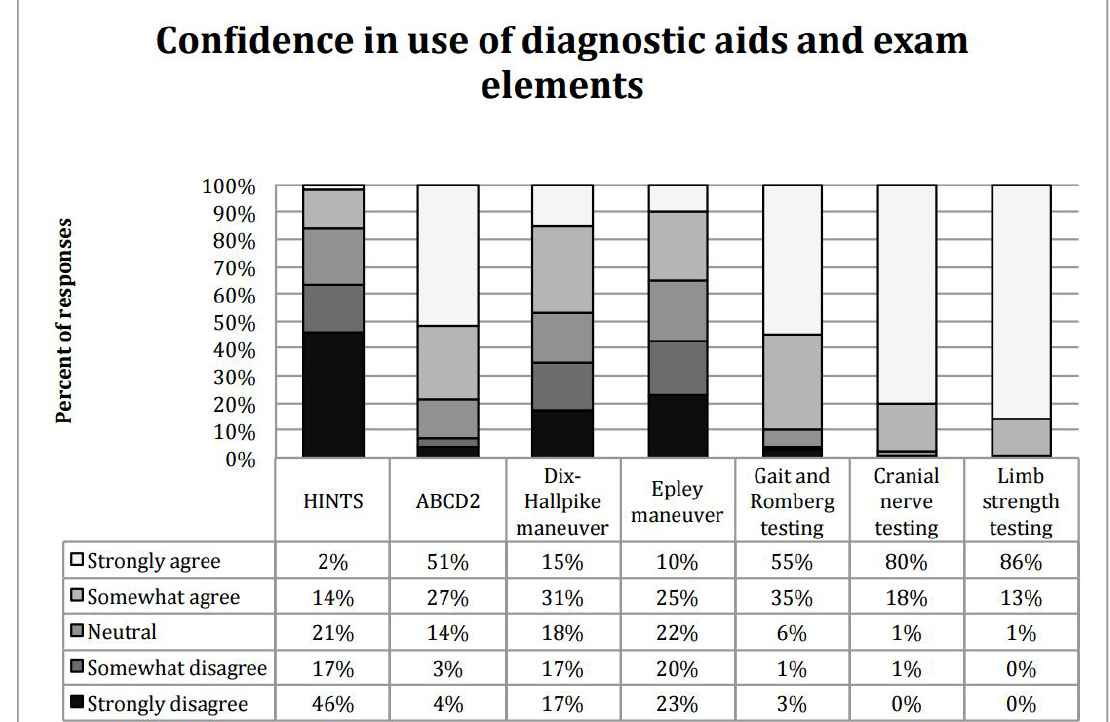
Figure 3. Agreement with feeling confidence in use of specific diagnostic aids and history and exam elements a . a Survey question 4, a-g, statement ii HINTS-Head impulse, nystagmus, test of skew ABCD2-to predict 30 day risk of stroke after transient ischemic attack